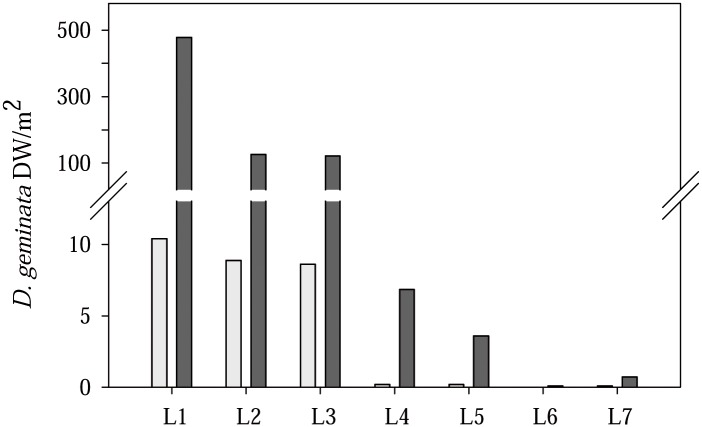
D. geminata biomass.D. geminata biomass (filaments gDW/m2) at every sample sites on June 22nd and August 31st, when macroinvertebrate and diatom samples were collected.